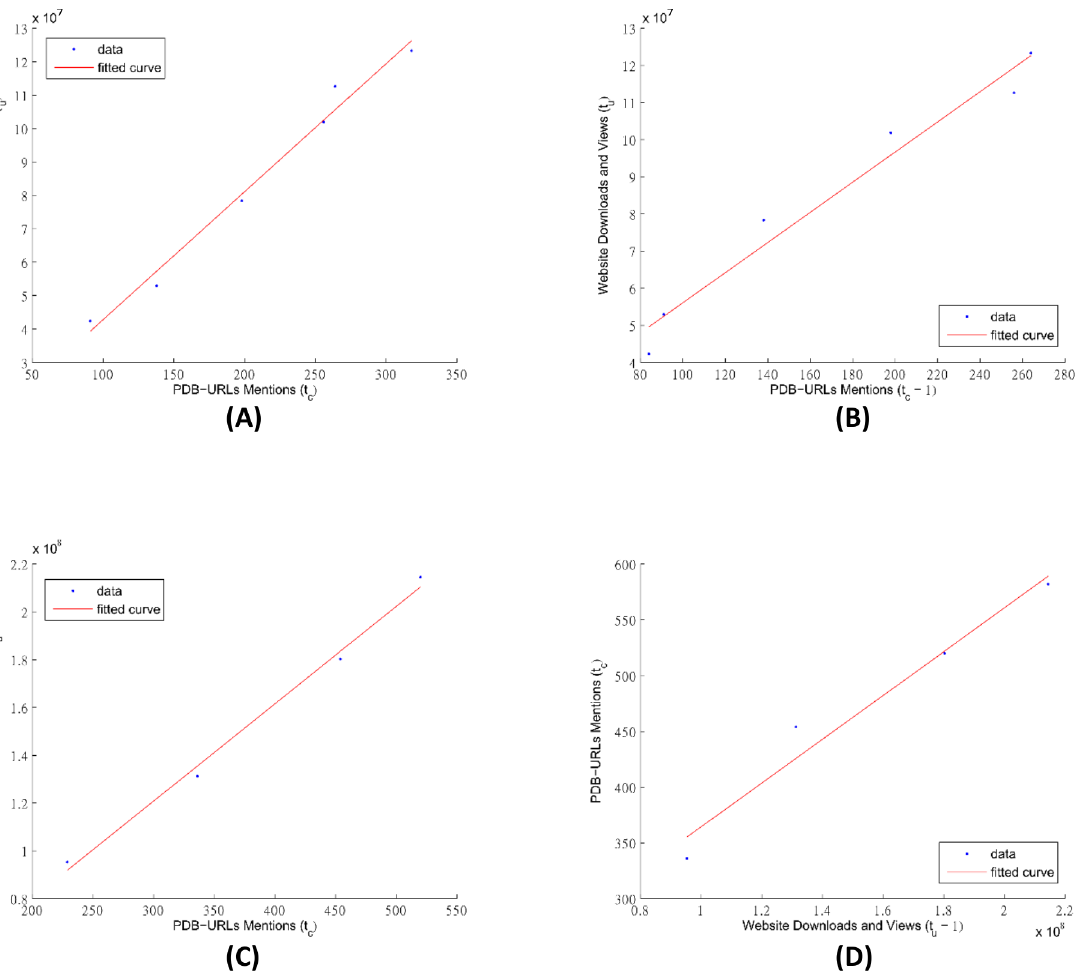
Fig 8. The plots of the fitting of linear models between the PDB URL mentions c and the website downloads and views u , referred to by their case No. ’ s in Table 4: (A)Case No. 3, y = u ( t ), and x = c ( t ), (B)Case No. 7, y = u ( t ), and x = c ( t − 1), (C)Case No. 11, y = u ( t ) + u ( t + 1), and x = c ( t ) + c ( t + 1), (D)Case No. 19, y = c ( t ) + c ( t + 1), and x = u ( t − 1) + u ( t